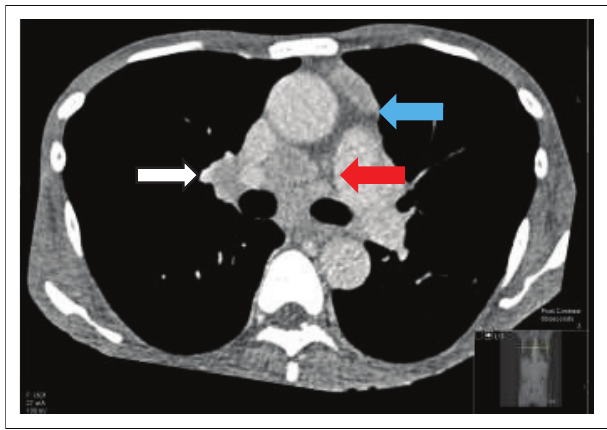
FIGURE 4: Axial computerised tomography of the chest demonstrating extensive mediastinal lymph nodes, the blue arrow points to the pre-vascular nodes, the white arrow points to the right hilar node and the red arrow points to the pre- carinal and subcarinal nodes.